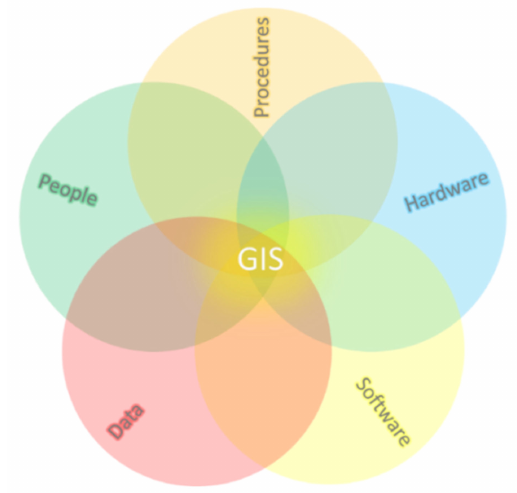
Figure 1. GIS system diagram (modified from